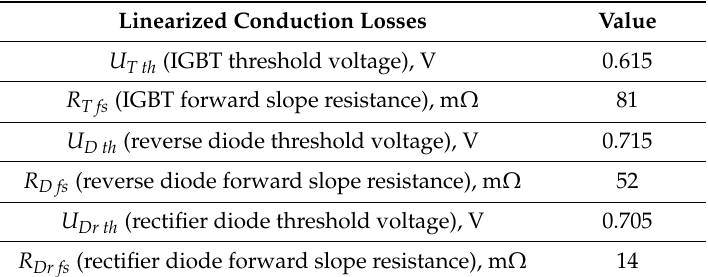
Table 6. Parameters from the IGBT and diodes I - V forward curves.